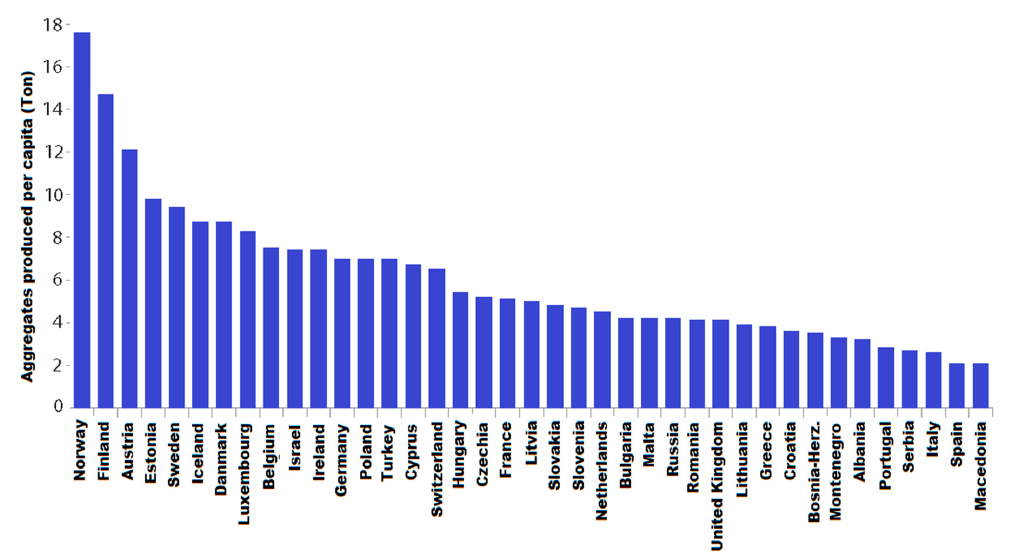
Figure 1. Aggregates production, in tonnes per capita, in 39 countries [3].